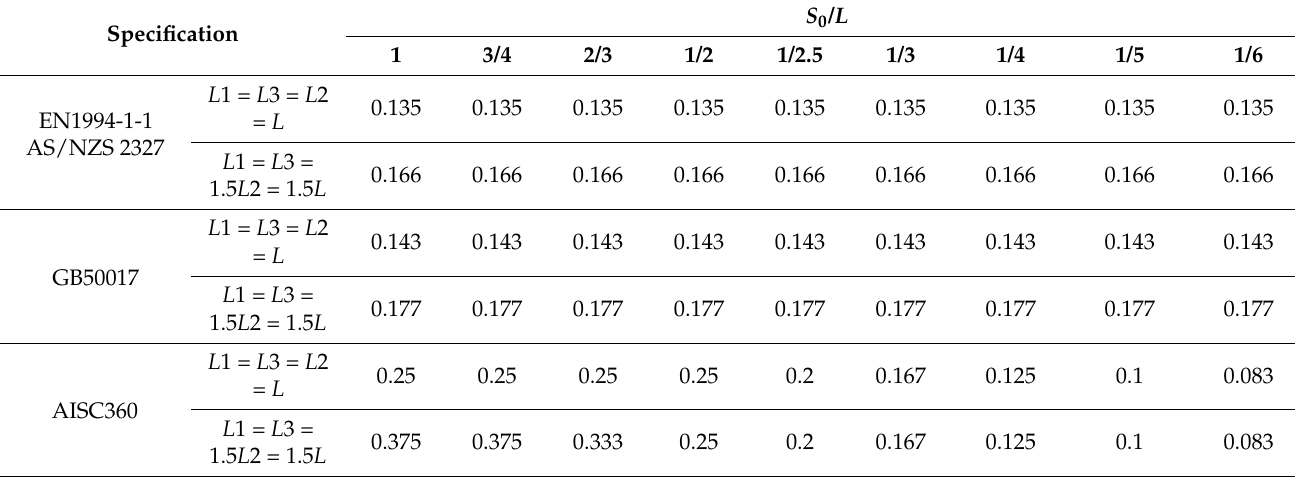
Table 3. The values of b e and L in the negative bending moment region considering b 0 = 0.01 L.